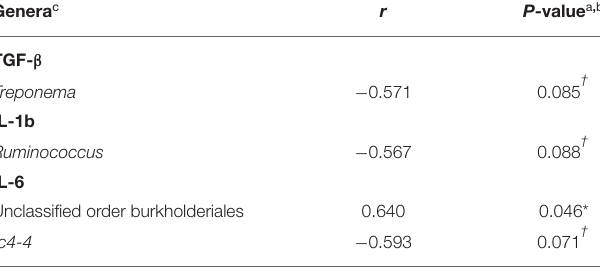
TABLE 2 | Pearson correlation coefficients ( r ) for TGF- β , IL-1b, and IL-6 and the relative abundance of genera within the uterus of resulting non-pregnant cows for d − 2.